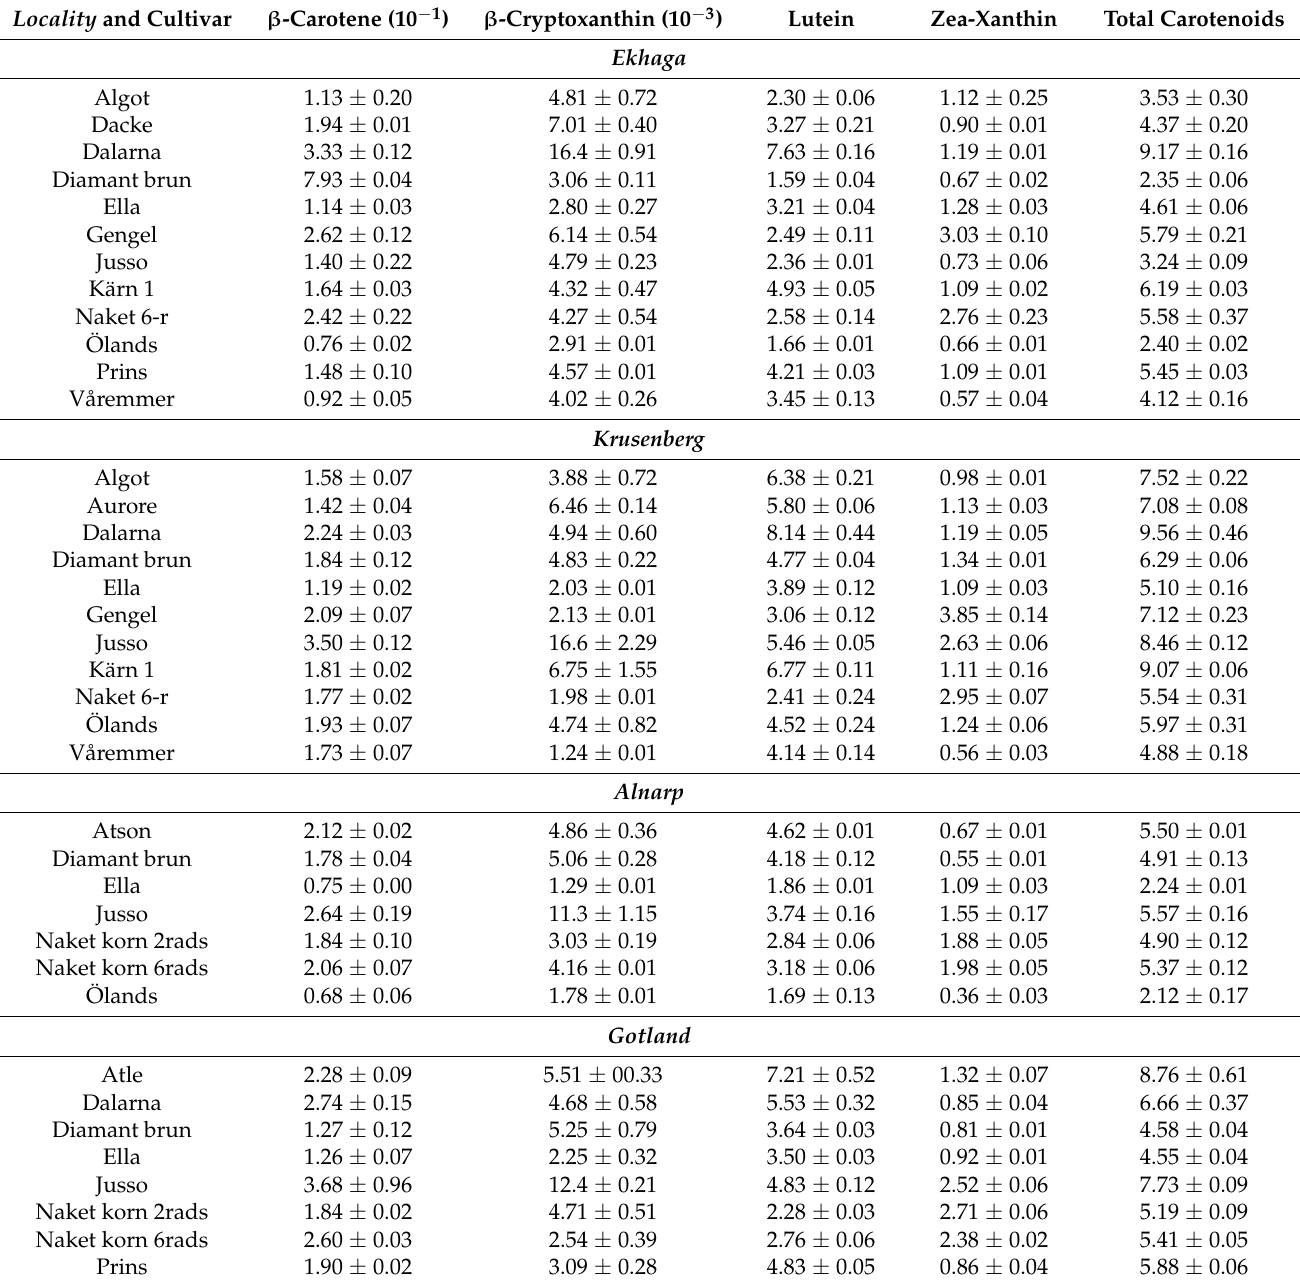
lutein, as well as for the total content of carotenoids (Table 3). Table 2. Mean value (mg/kg) ± standard deviation of the different carotenoids per cultivation locality ( italics ) and cultivar. Locality and Cultivar